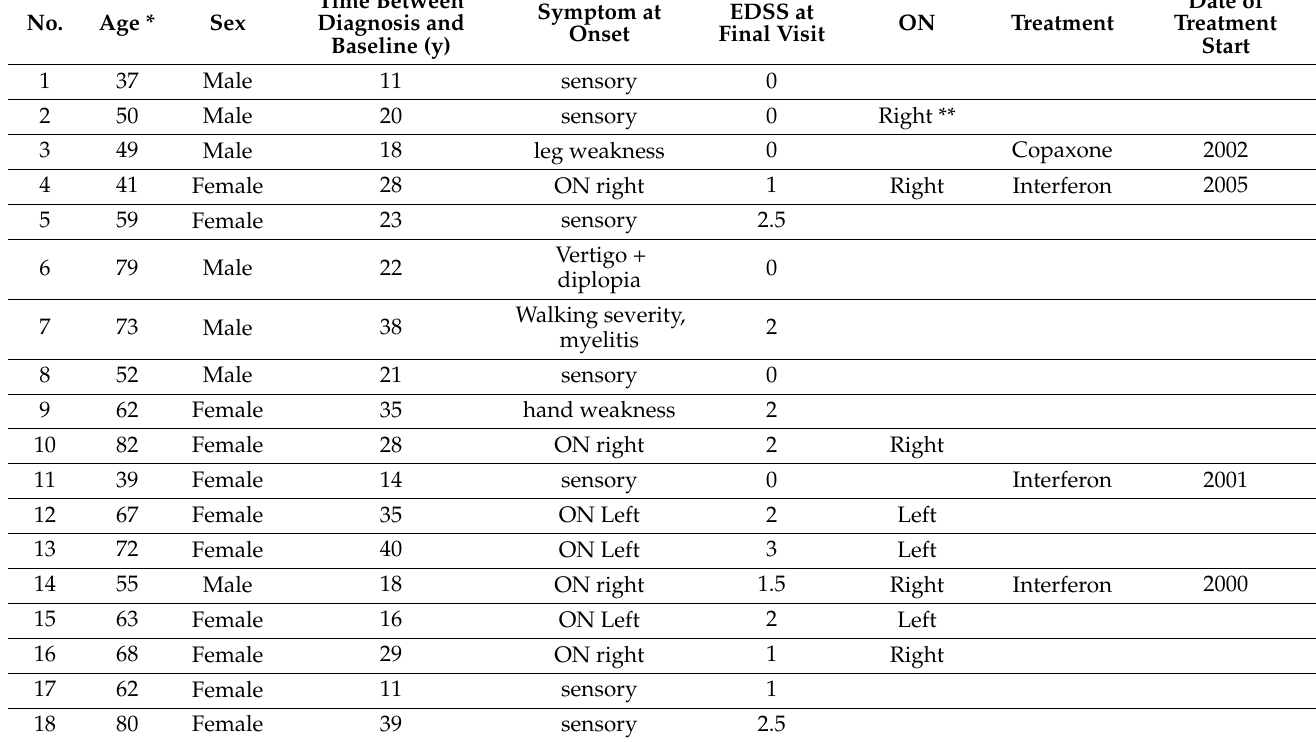
(F/M) female/male, (SD) standard deviation. Table 2. Clinical characteristics of the patients with